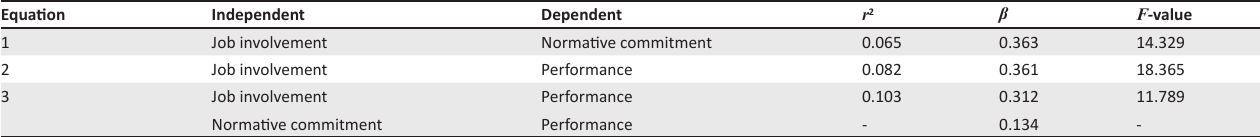
TABLE 4: Mediation test for normative commitment.